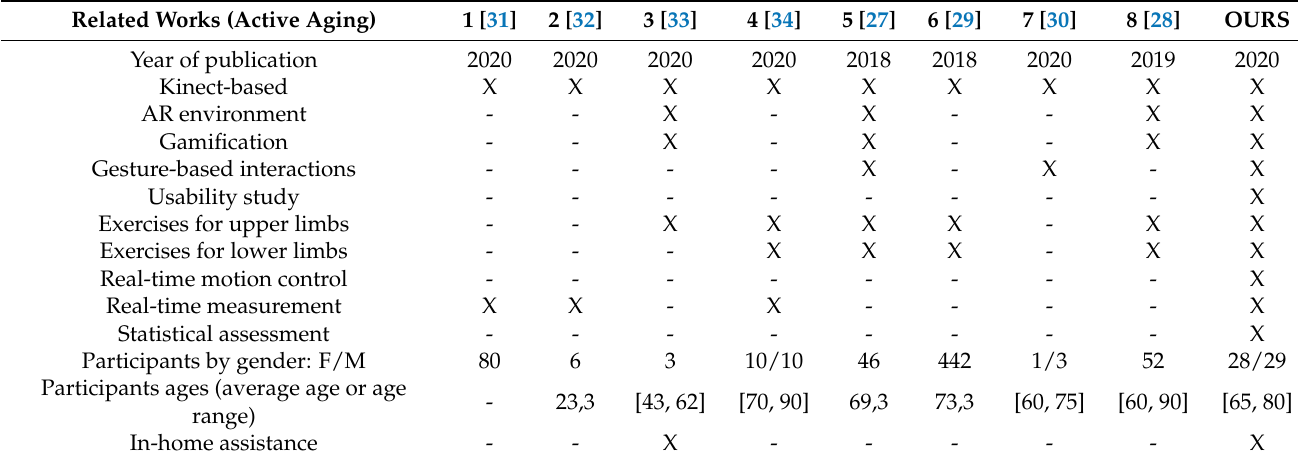
Table 1. Comparison of recent publications on active aging and this work, considering both features of the systems and methods for evaluating their